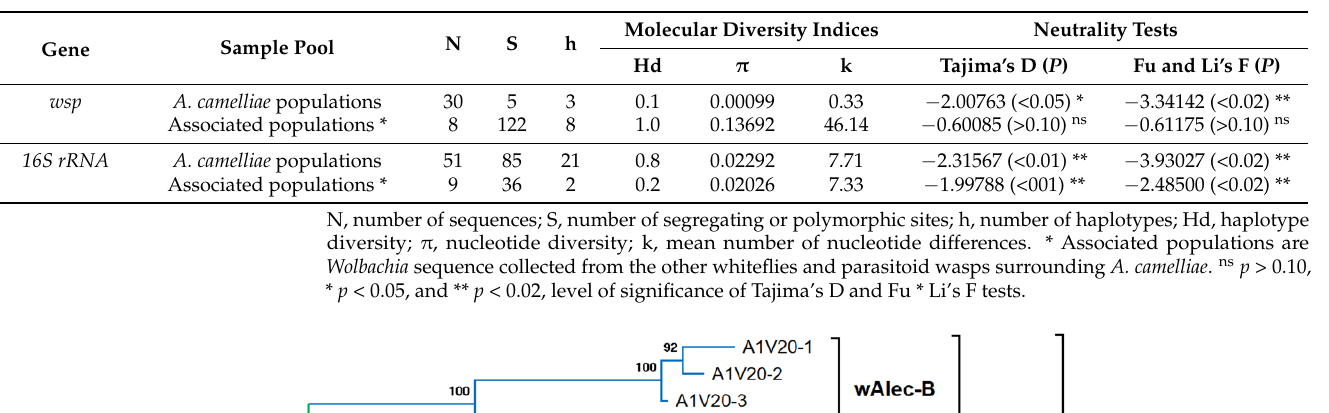
Table 4. Haplotype diversity of Wolbachia in A. camelliae haplotype B1 was estimated from a 364 bp wsp and 385 bp 16S rRNA of Wolbachia gene fragments.